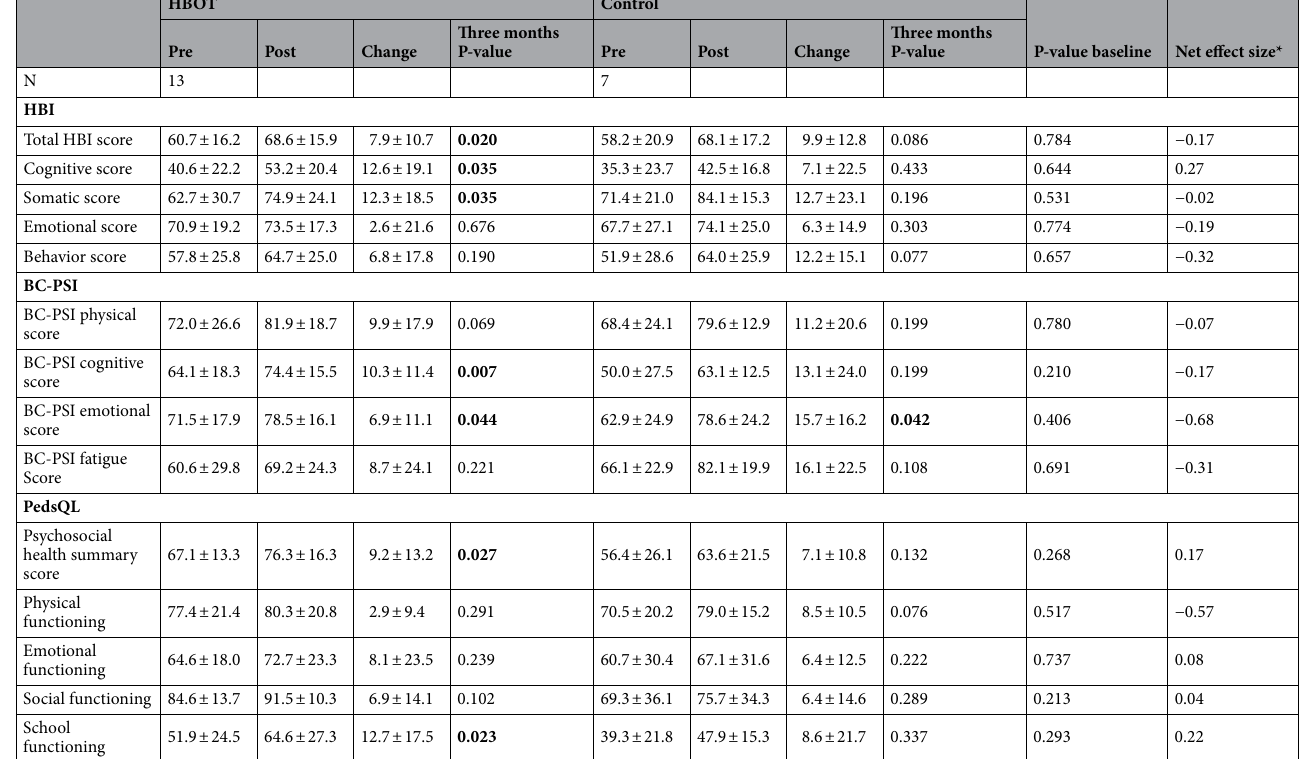
Table 3. PPCS symptoms changes. Baseline comparison of p-values test the null hypothesis of equal means of the two groups at the baseline using an unpaired t-test; three months comparison of p-values test the null hypothesis of equal means of each group pre-post intervention (HBOT/sham respectively) using a paired t-test; bold, P < 0.05, net effect size is the subtraction of Cohen’s D effect size of the control group from the HBOT group Cohen’s D effect